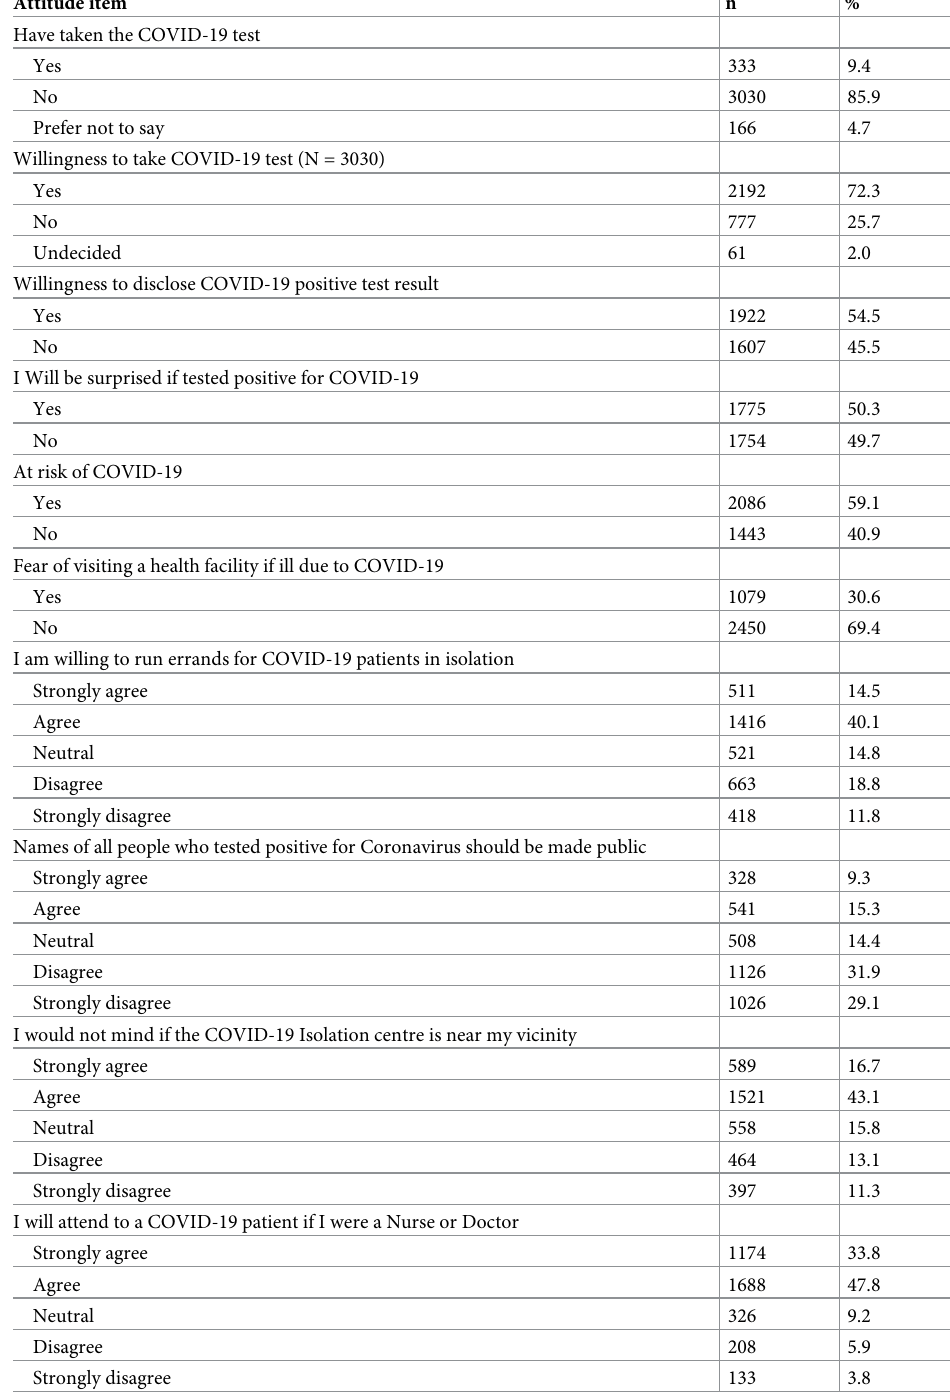
Table 3. COVID-19 related attitudes of